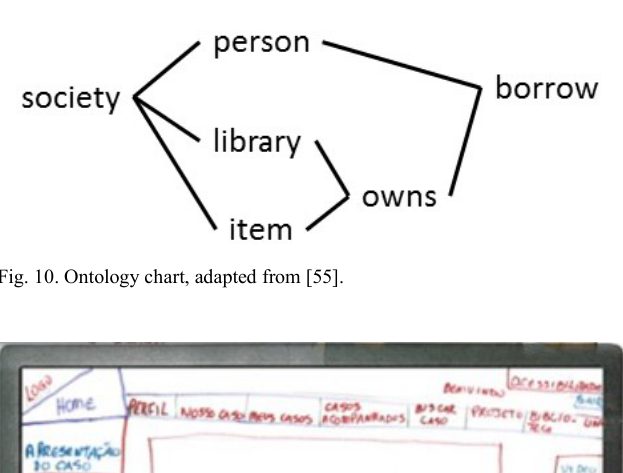
Fig. 9. Picture of an actual Evaluation Frame used in a semioparticipatory workshop. From [5].